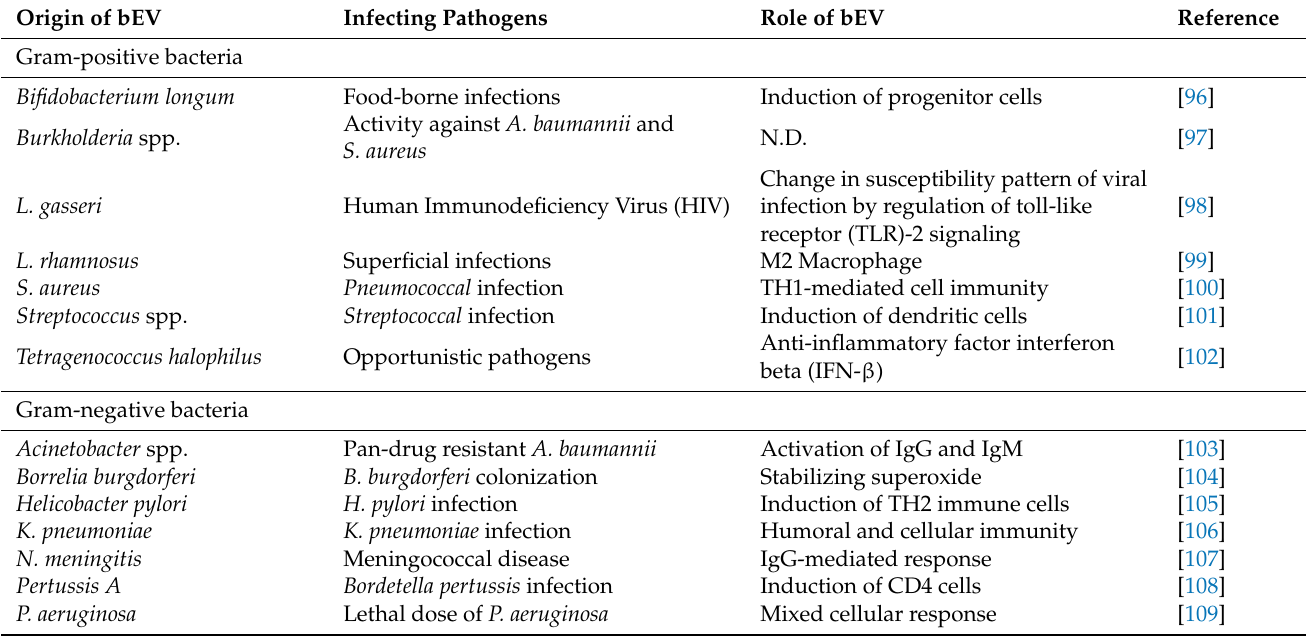
Table 1. bEVs involved in the pathogenic infections and their